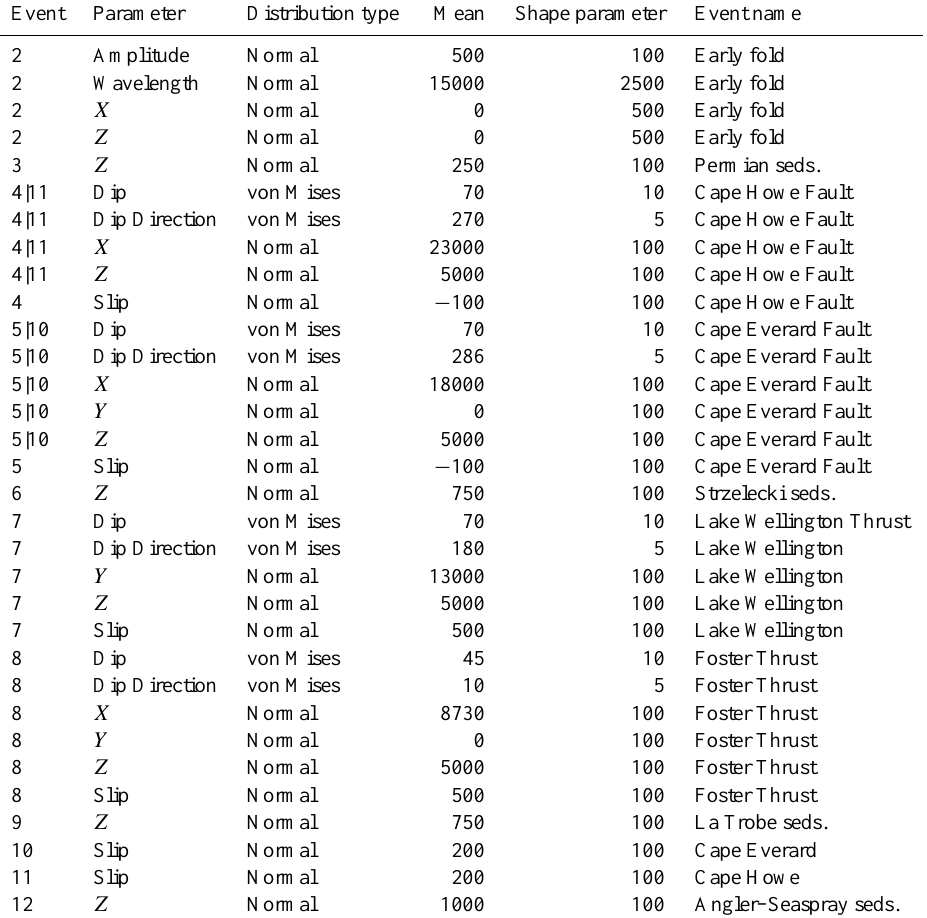
Table C1. Distributions and parameters for Gippsland Basin